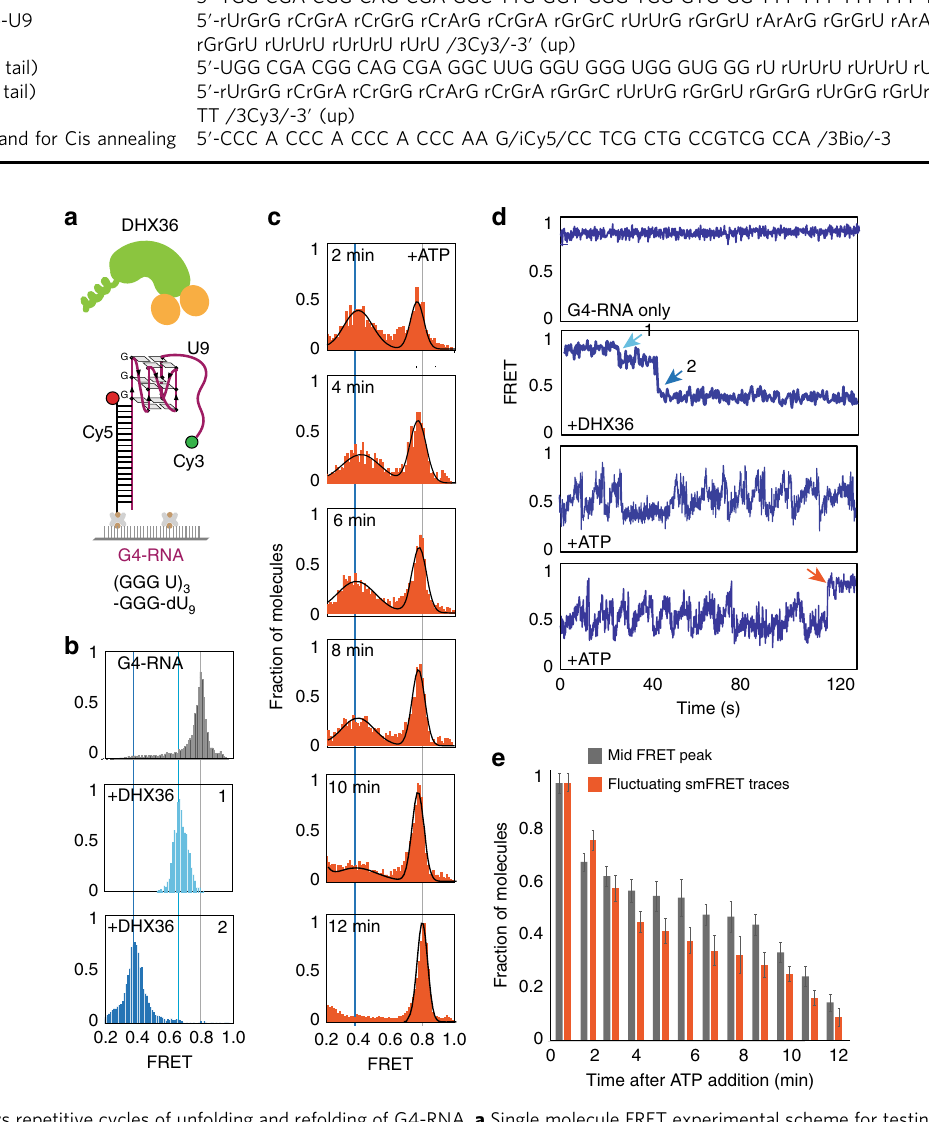
Fig. 1 DHX36 displays repetitive cycles of unfolding and refolding of G4-RNA. a Single molecule FRET experimental scheme for testing DHX36 activity on G4-RNA. Two FRET dyes are attached to either end of G4. b FRET histograms taken at substrate only (top, 0.8 FRET peak), after DHX36 binds ssRNA (middle, 0.65 FRET peak) and after DHX36 engages with G4 (bottom, 0.4 FRET peak). c FRET histograms taken 0 – 12 min after 1 mM ATP is added. d Representative single molecule traces displayed in each condition. The bottom two traces represent continuous unfolding-refolding activity without (top) and with (bottom) DHX36 dissociation. e Quantitation of the fraction of middle FRET and FRET fl uctuation over time plotted with standard error of